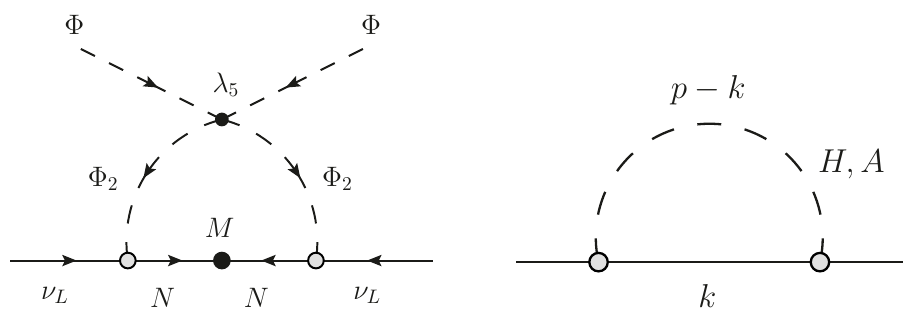
Figure 1 . Left: the standard diagram representing the radiative neutrino mass generation in the scotogenic model. Right: the actual H and A -mediated loop diagrams one needs to calculate. of the scalar sector parameter space. The second, inert doublet (cid:8) 2 produces two neutral scalars denoted traditionally as H and A plus a pair of charged Higgses H (cid:6) , and the